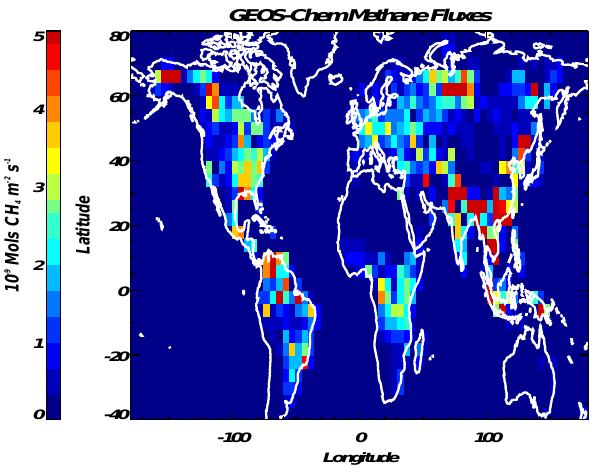
Figure 3. Methane fluxes used in GEOS-Chem model.